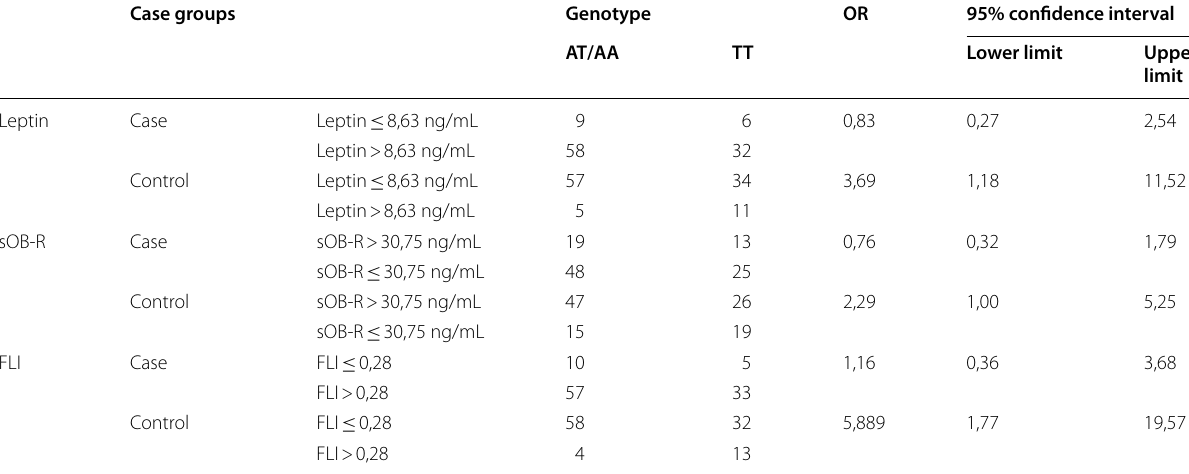
Multiple logistic regression test